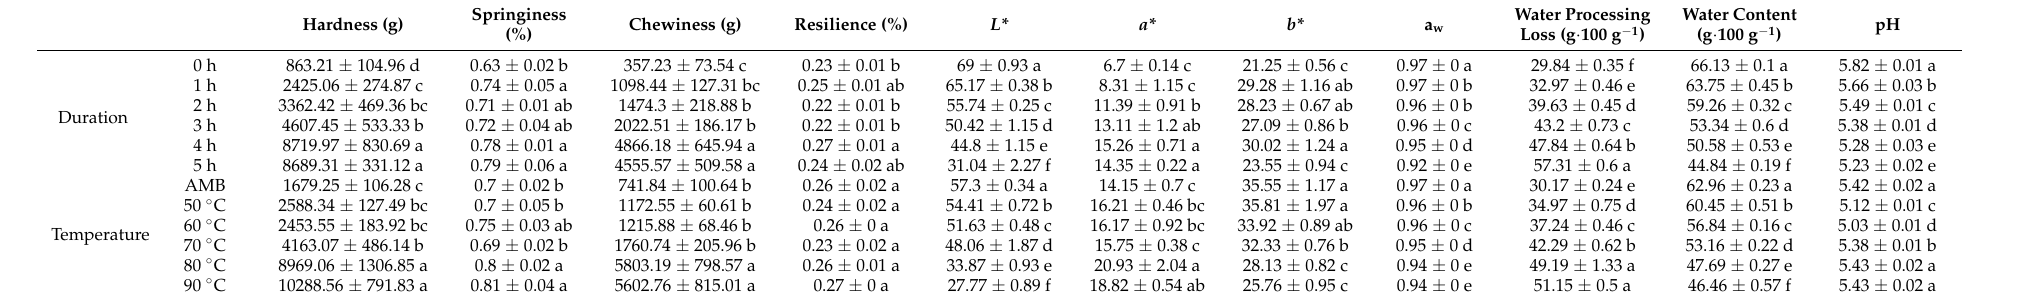
Group 1: the meat patties were smoked for 0, 1, 2, 3, 4 and 5 h at 70 ◦ C. Group 2: the meat patties were smoked for 3 h, at ambient temperatures (AMB), 50, 60, 70, 80 and 90 ◦ C. Data are presented as means ± standard deviations ( n = 3). Different letters in each treatment group represented significant differences at p <